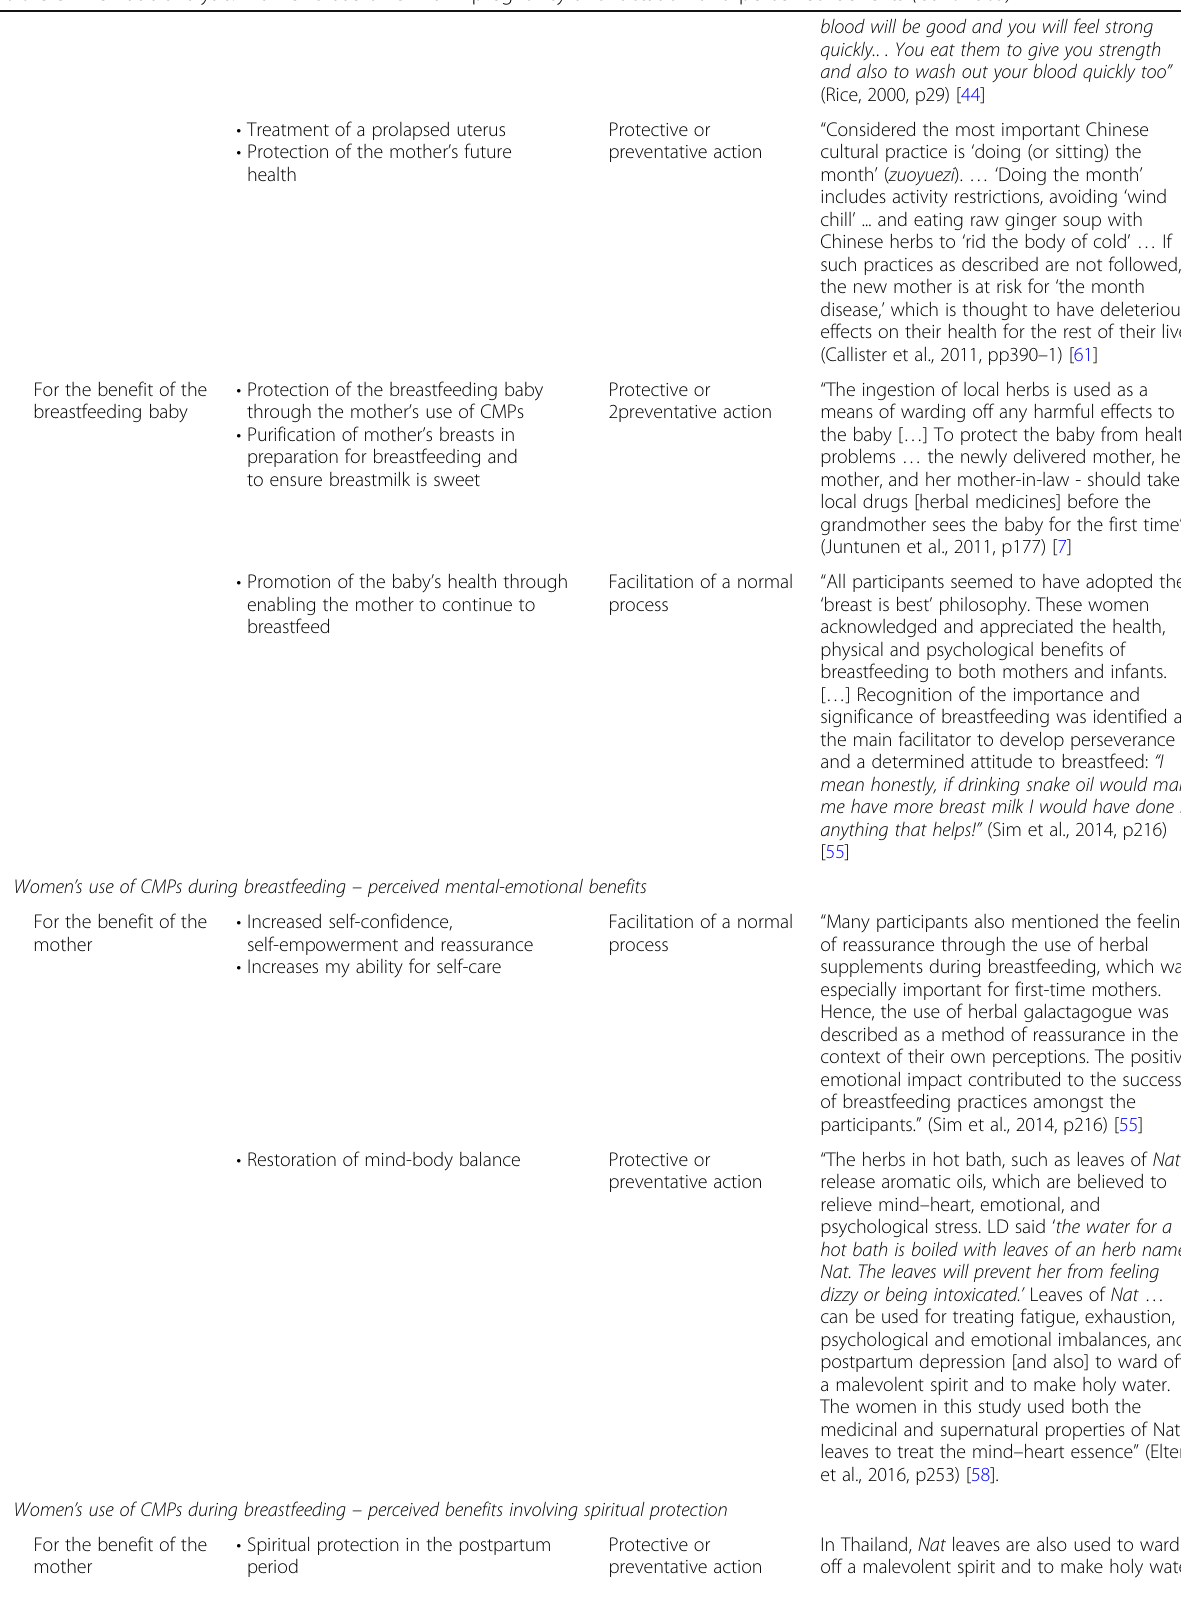
Table 3 Thematic analysis: women ’ s use of CMPs in pregnancy and lactation and perceived benefits